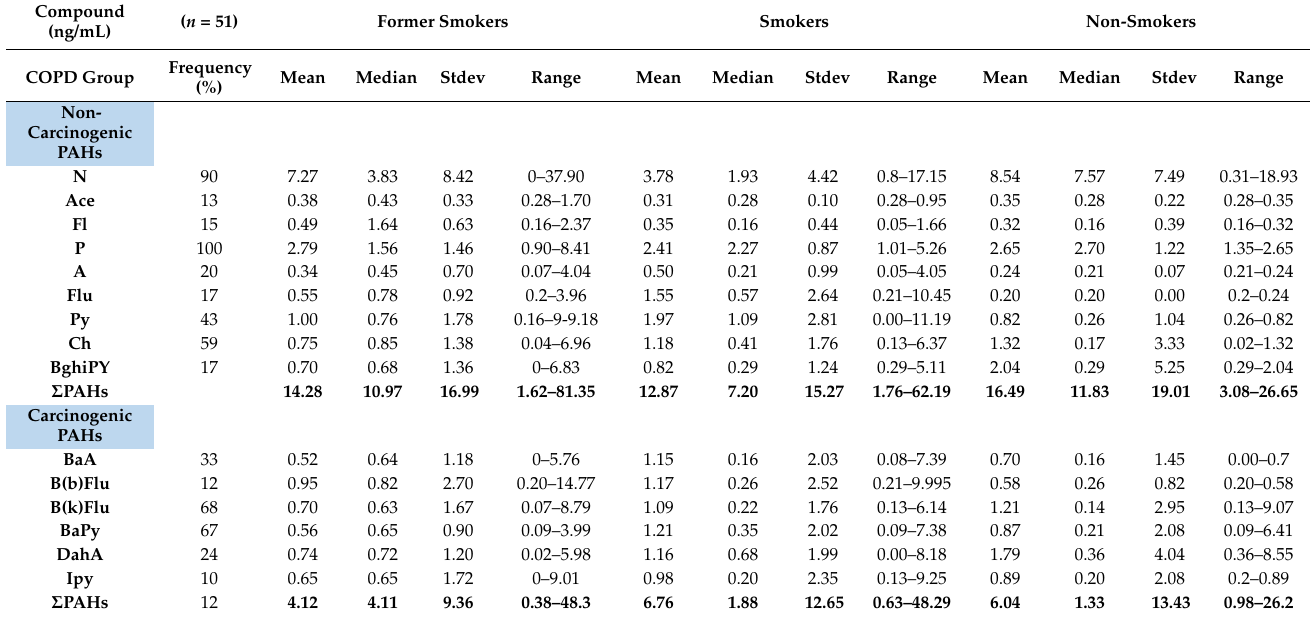
Table 3. PAHs concentrations (ng/mL) in human blood serum of COPD